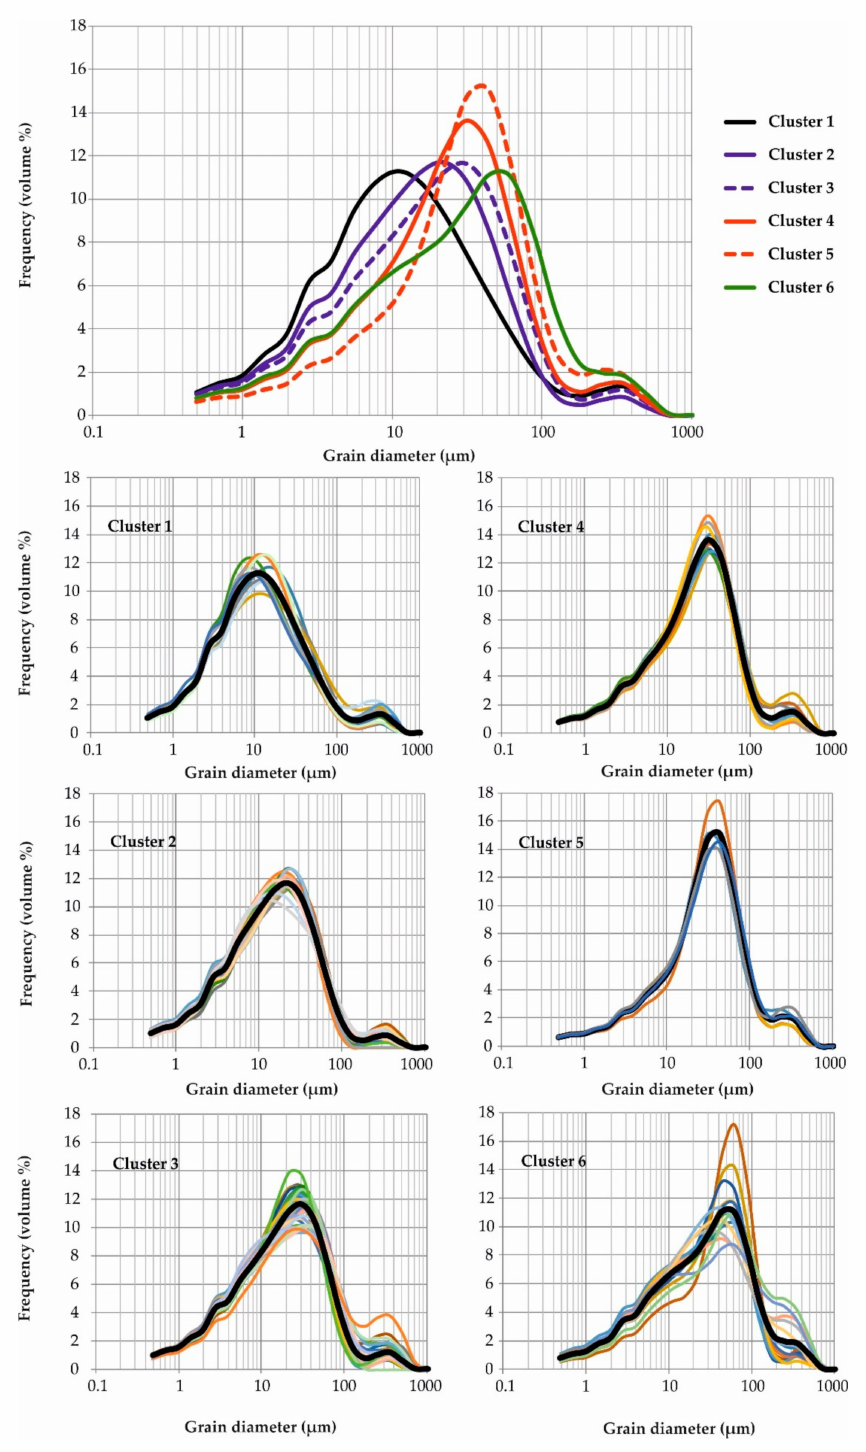
Figure 4. Mean grain size distributions of the six extracted clusters (upper plot). The lower plots report the details of the grain size distribution of each cluster, from the finest mode (cluster 1) to the coarsest mode (cluster 6). The black lines represent the mean grain size curves. The grain size trend along the three box cores is represented by the vertical distribution of the clusters, (Figure 6). In the same graph the number of dropstones (fraction >1 mm) recovered in the fixed amount of sediment used for the grain size analysis is used as a proxy of the vertical flux linked to the Ice Rafted Debris (IRD). BC02 and BC03 show